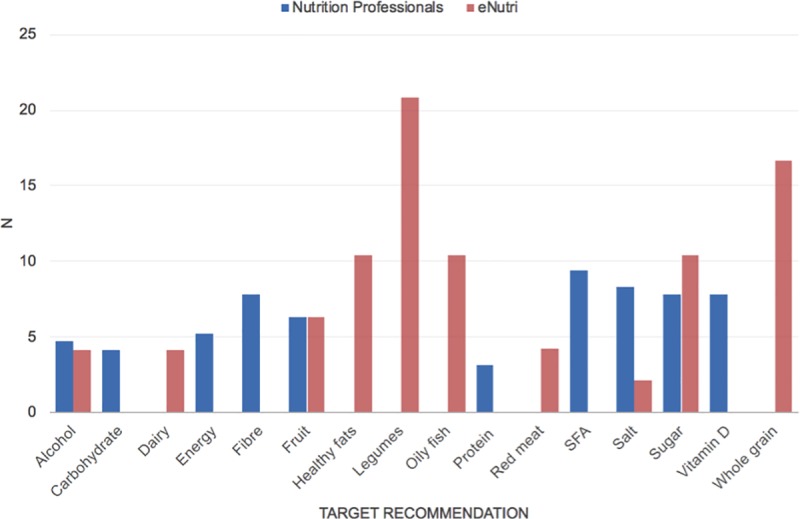
Number of times each target recommendation was selected by nutrition professionals and by the eNutri app for all scenarios combined.